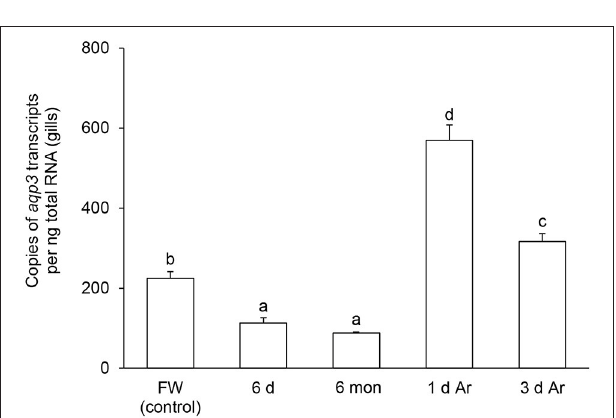
FIGURE 7 | The absolute quantification of mRNA expression level (copies of transcript per ng total RNA) of aquaporin 3 ( aqp3 ) in the gills of Protopterus annectens kept in fresh water on day 0 (FW; control), after 6 days (d; induction phase) or 6 months (mon; maintenance phase) of aestivation, or after 1 or 3 d of arousal (Ar) from 6 mon of aestivation. Results represent means ± S.E.M ( N = 4). Means not sharing the same letter are significantly different ( P <